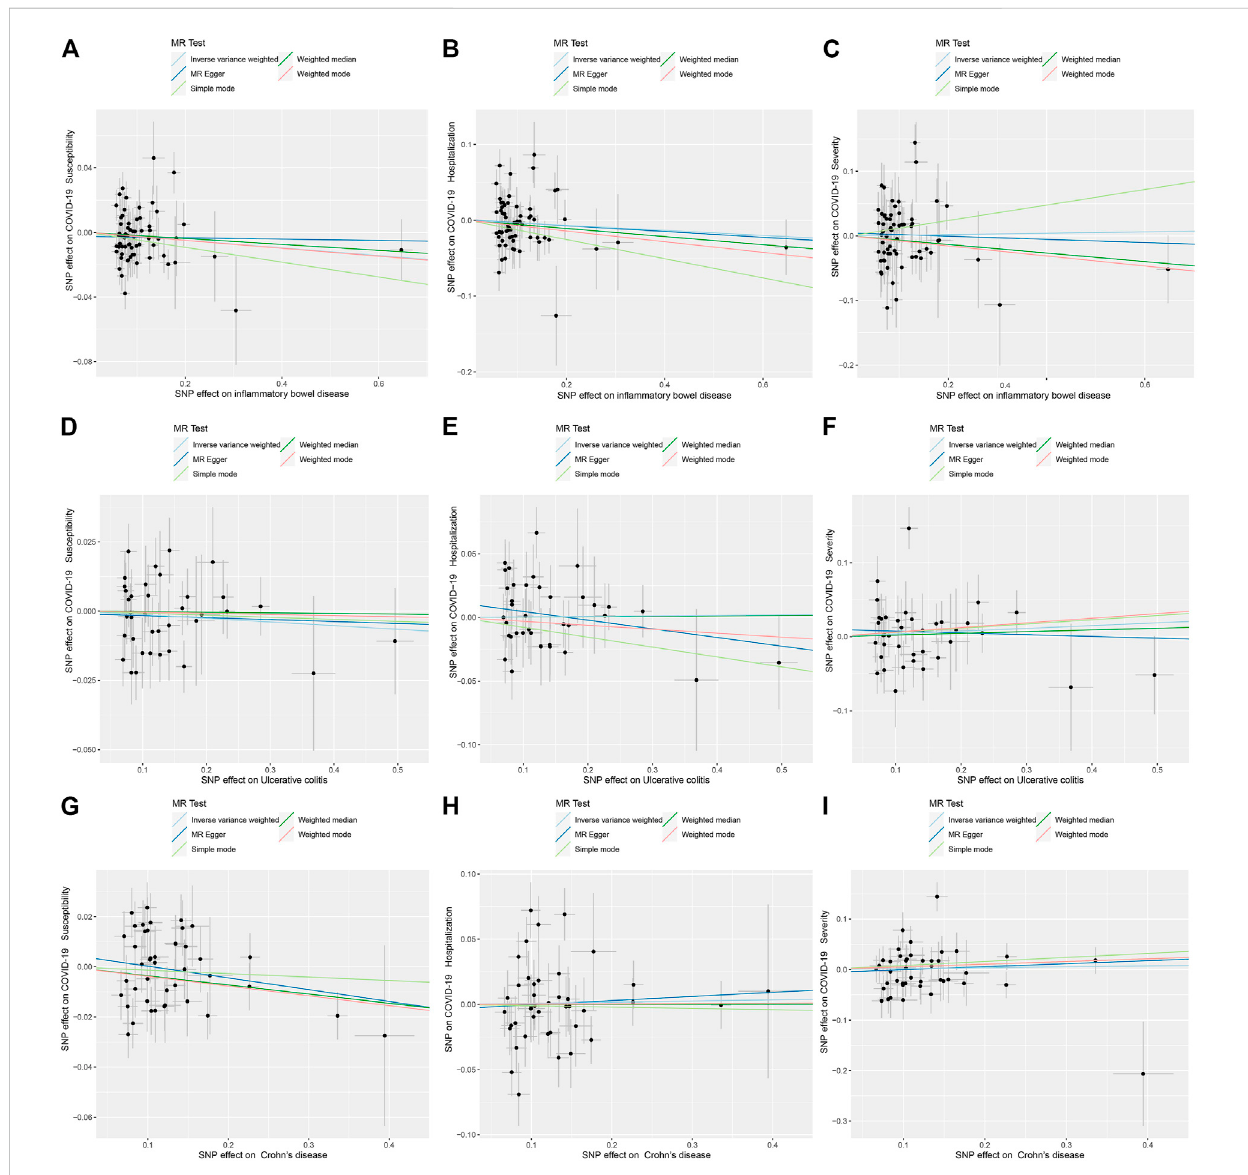
FIGURE 3 Scatter plots for causal SNP effect of IBD (including UC and CD) on COVID-19 susceptibility, hospitalization, and severity. (A) Effect of IBD on COVID-19 susceptibility; (B) Effect of IBD on COVID-19 hospitalization; (C) Effect of IBD on COVID-19 severity; (D) Effect of UC on COVID-19 susceptibility; (E) EffectofUConCOVID-19hospitalization; (F) EffectofUConCOVID-19severity; (G) EffectofCDonCOVID-19susceptibility; (H) Effect of CD on COVID-19 hospitalization; (I) Effect of CD on COVID-19